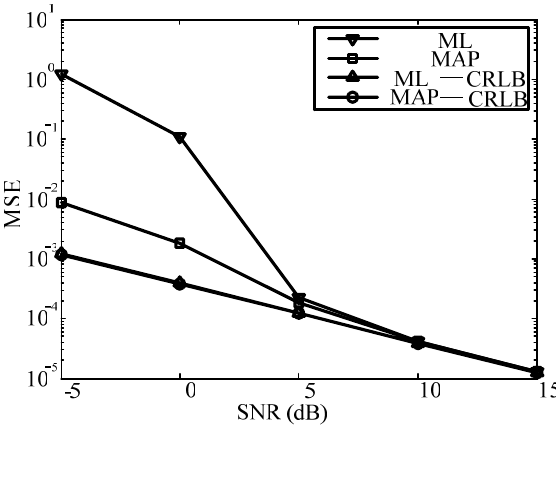
Fig.2.Performance comparison between MAP and ML in 2 1 × system (